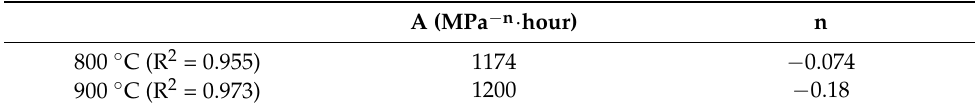
Figure 5. Stress–rupture time graph at 800 °C and 900 °C [25–27]. Table 3. Value of parameters A and n.